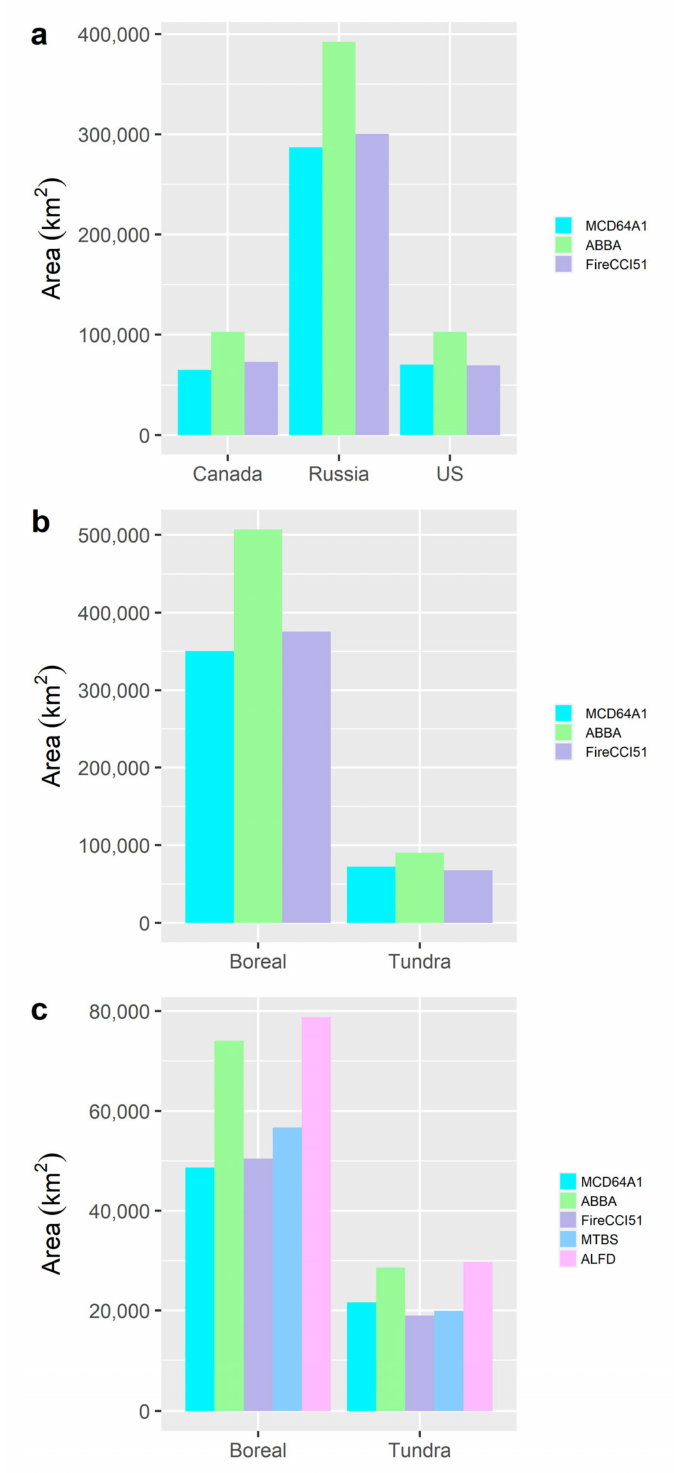
Figure 5. Comparisons of the total area of burned areas as mapped by the MCD64A1, ABBA, and FireCCI51 products broken down by ( a ) countries and ( b ) biomes over the circumpolar domain. ( c ) shows the total area of burned areas as mapped by the three burned area products in Alaska in comparison to the MTBS and ALFD burned